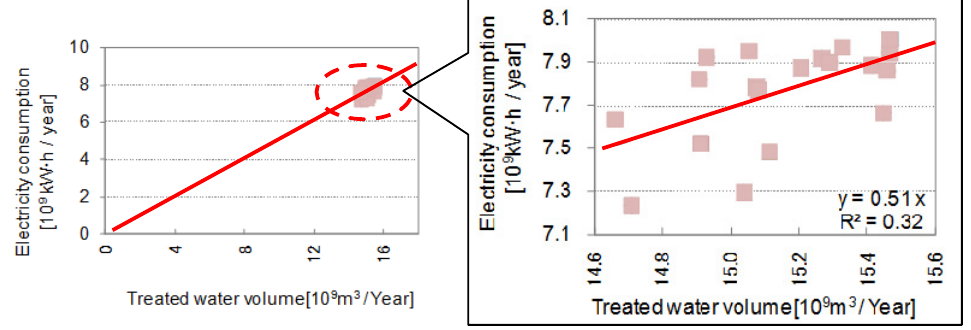
Figure 7. Relationship between electricity consumption and treated water volume for waterworks.